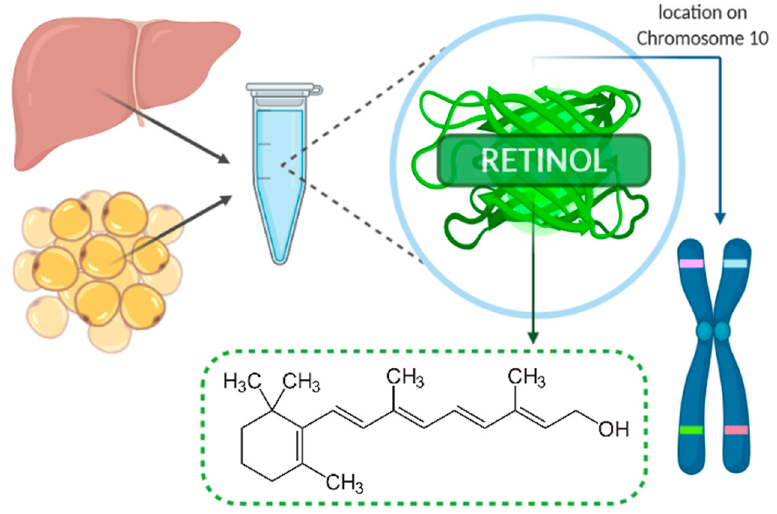
Figure 1. Retinol-binding protein 4 (RBP4).